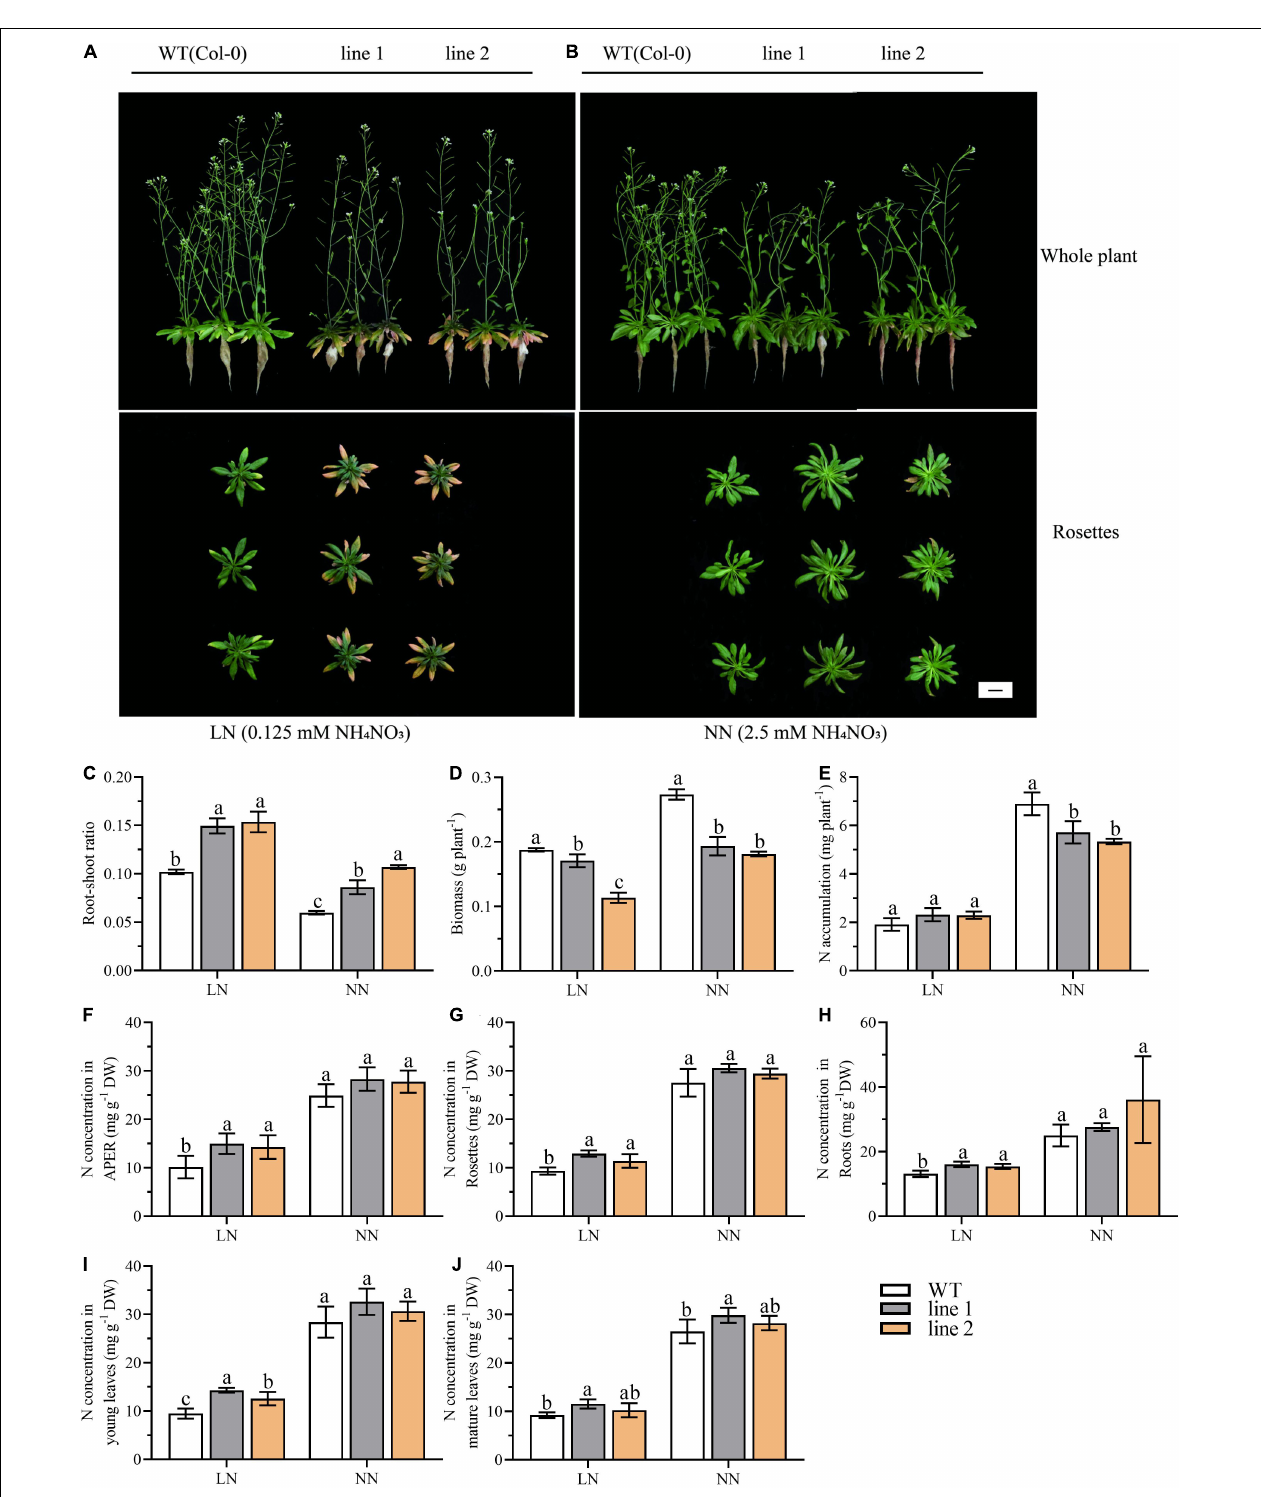
FIGURE 2 | The CsATG101 overexpression and wild type A. thaliana in response to N levels. Plants were hydroponic cultured for 3 weeks under NN and then under LN (A) and NN (B) for 2 weeks. (C) Root-shoot ratio (Root biomass/shoot biomass). (D) Biomass of whole plant ( n ≥ 5). (E) Total N accumulation at whole plant level ( n ≥ 5). The N concentration in APER (F) , Rosettes (G) , Roots (H) , Young leaves (I) , and Mature leaves (J) ( n ≥ 5). Three biological replicates were performed. Data are means ± SD . Significant differences are indicated by letters (ANOVA; P ≤ 0.05). WT, wild type (Col-0); line 1 and line 2, two transgenic lines; APER, Aerial part excluding rosette. LN, low nitrogen, 0.25 mM N (0.125 mM NH 4 NO 3 ); NN, normal nitrogen, 5 mM N (2.5 mM NH 4 NO 3 ). Scale bar = 2 cm.